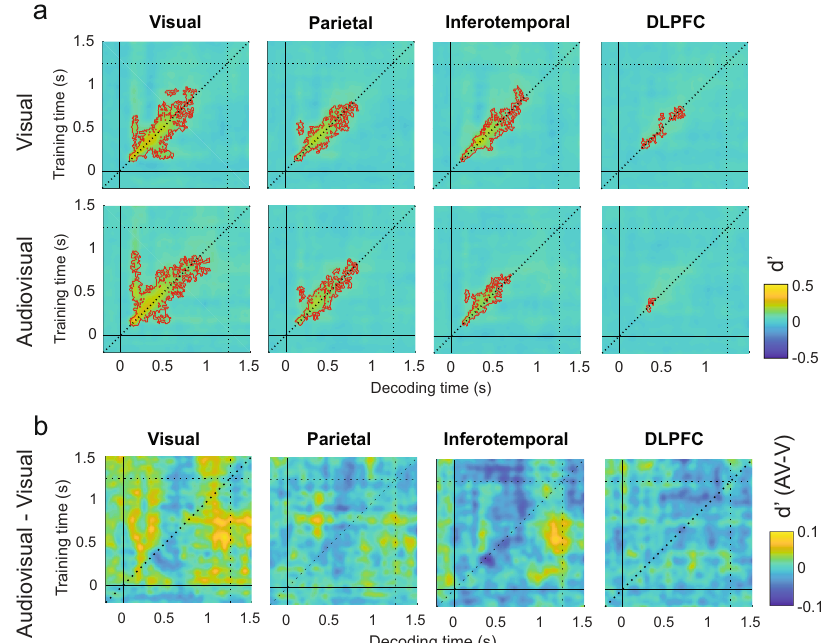
Fig. 8 Visual sensitivity decoded from visual and audiovisual task-irrelevant stimuli across ROIs. Temporal generalization matrixes illustrate ( a ) the decoded sensitivity parameters (d ′ ) for the high contrast condition (S − vs. S ++ ) in the visual (upper TGMs) and audiovisual (bottom TGMs) conditions and their difference ( b ) across ROIs. Red contours delimit signi fi cant clusters. Vertical and horizontal dotted lines represent the response phase onset.